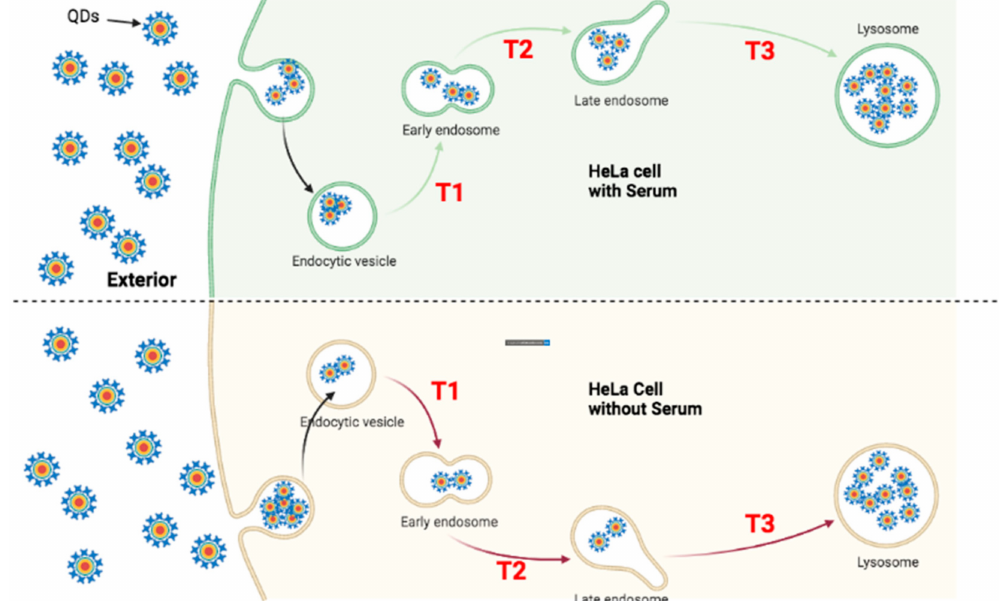
Figure 13. Proposed transportation kinetics of QDs in HeLa cells grown in the media with and without serum for 24 h. The models depict that the intracellular traffic kinetics of QDs in HeLa cells grown with serum ( Upper ) is noticeably distinctive from that of HeLa cells grown without serum ( Bottom ) after 24 h of QD treatment. (T1) indicates the transition of QDs from the endocytic vesicle towards the early endosome; (T2) indicates the transition of QDs from the early endosome towards the late endosome; (T3) indicates the transition of QDs from the late endosome to the lysosome. Each green arrow represents a slower transit rate of QDs in comparison with its counterpart rate indicated in red. Each red arrow represents a faster transit rate of QDs in comparison with its counterpart rate indicated in green.